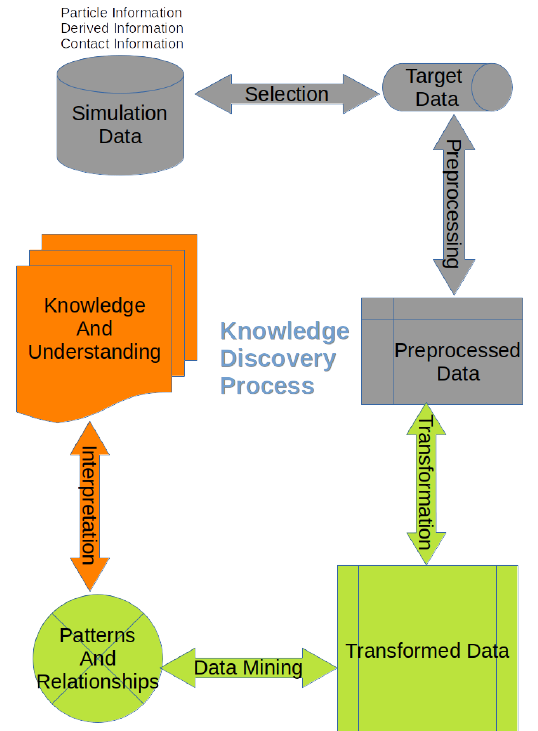
Figure 2: Outline of the Knowledge Discovery Process